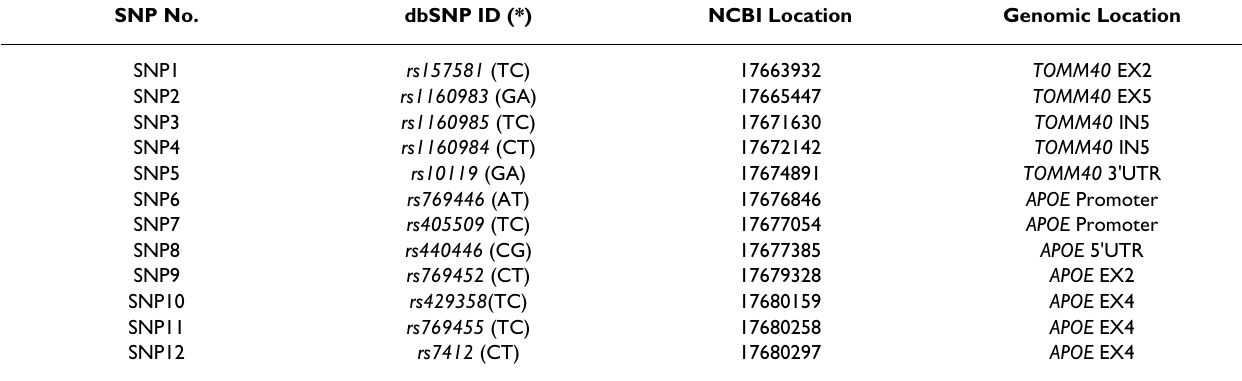
Table 1: Distribution of the studied SNPs in the APOE gene region SNP No.